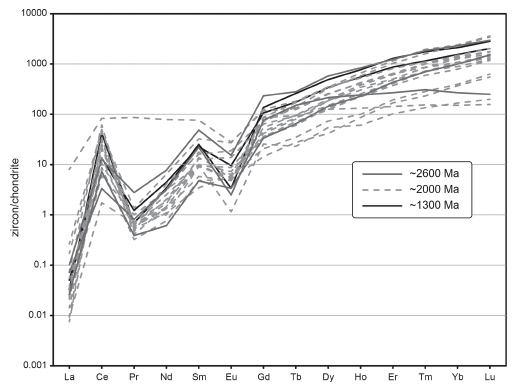
Figure 11. Chondrite-normalized plots for inherited zircon older than